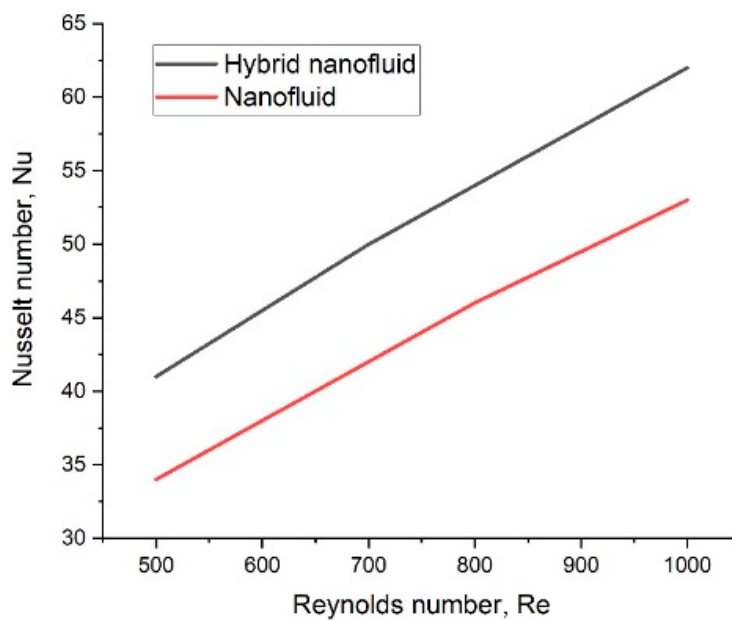
Figure 3. Comparison of 𝑁𝑢 vs. 𝑅𝑒 with water and oil + water-based nanofluids.